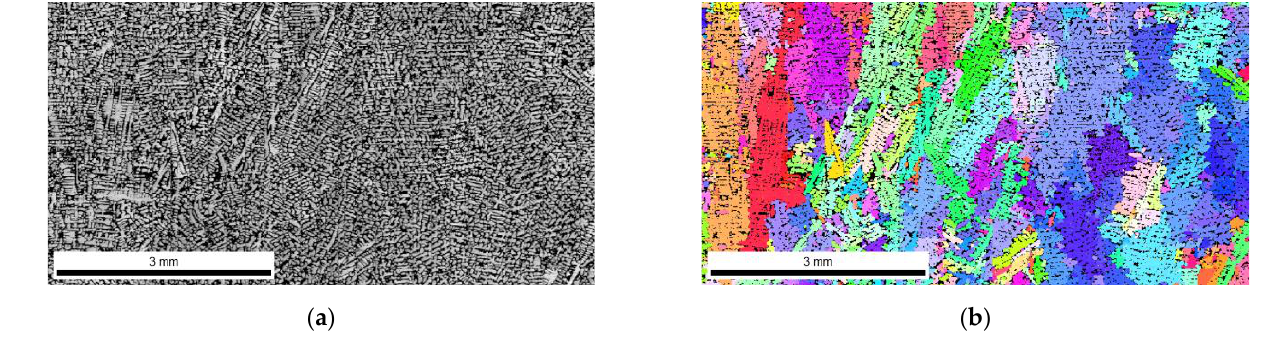
Figure 6. Structure of chromium cast iron in a 20 mm thick plate. ( a ) light microscope; ( b ) EBSD.